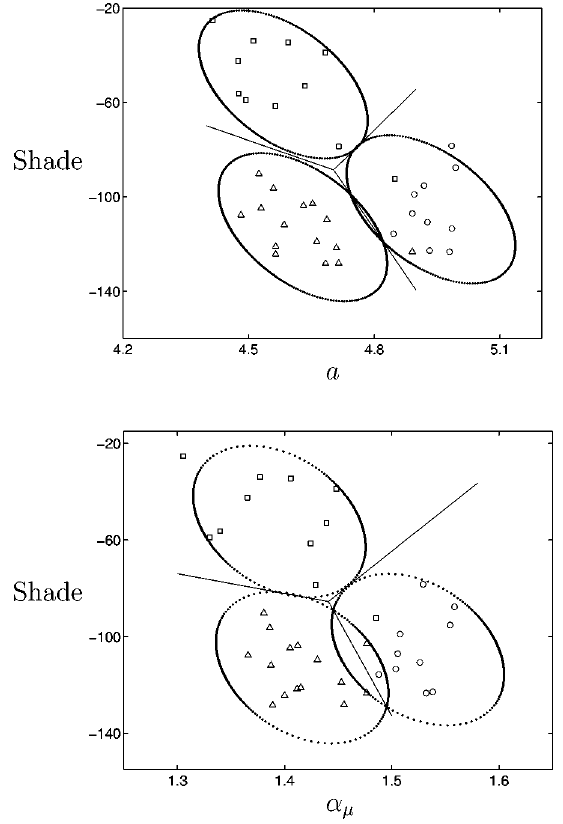
Fig. 11. The Gray Level Coocurrence Matrix feature, Shade, is plot- ted versus the features a (top) and (cid:11) (cid:22) (bottom) as obtained by the 1D polygonization method, for samples from the normal+regenerating ( (cid:14) ), noduli ( 4 ) and tumour ( 2 ) classes. The principal axes of the ellipses are given by the eigenvectors of the pooled covariance ma- trix and the ellipses contain 95.4% of the probability. The decision boundaries for the classifier computed from the whole data set are also